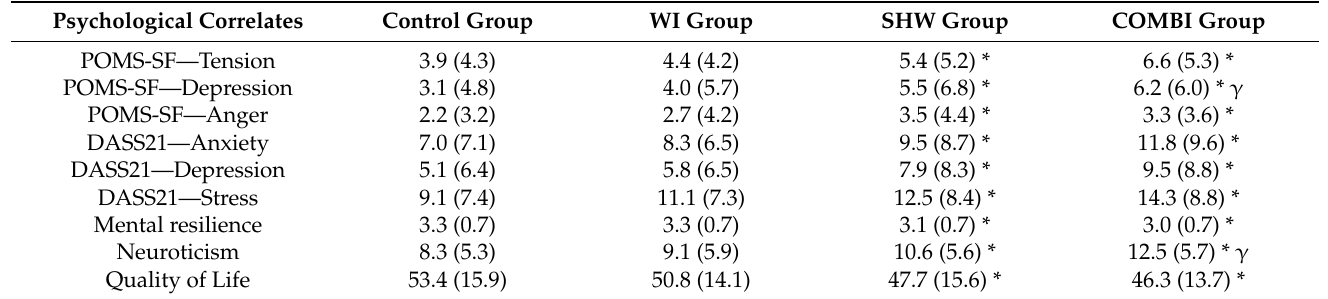
Table 2. Psychological correlates of wound infection and slow-healing